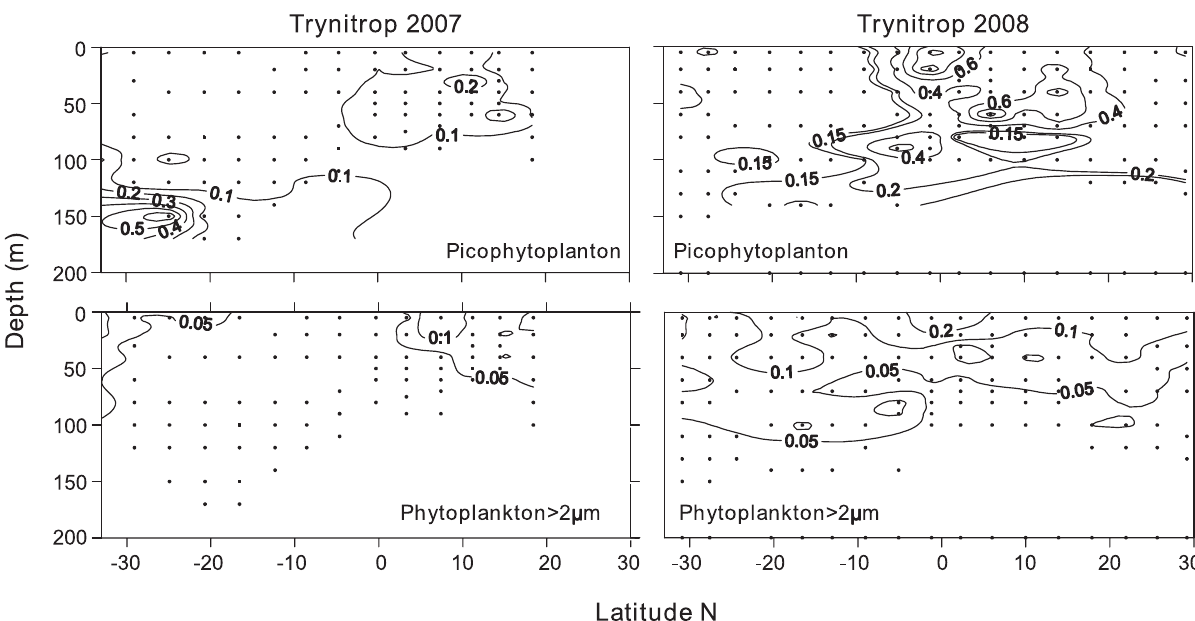
Fig . 8. – Latitudinal distribution of the size-fractionated growth rate (d -1 ). Left panel, Trynitrop 2007; right panel, Trynitrop 2008